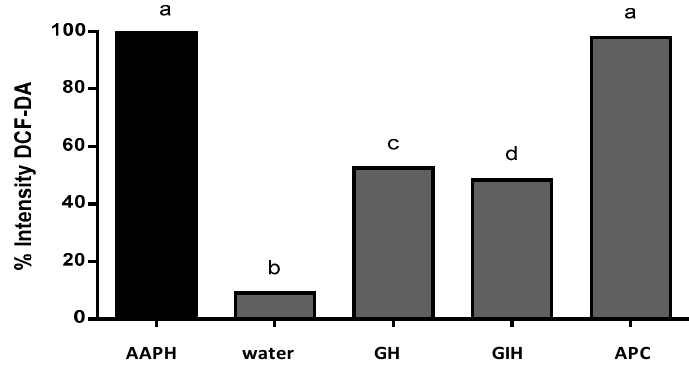
Figure 6. % of intensity by 2,7-dichlorofluorescein diacetate (DCFH-DA) fluorescence in the presence of AAPH. AAPH (positive control), water (basal control without AAPH), GH (gastric hydrolysate incubated with AAPH), IH (intestinal hydrolysate incubated with AAPH), and APC (amaranth protein concentrate incubated with AAPH). Results were analyzed using one-way ANOVA and followed by Tukey´s test. Different letters represents significant differences between samples as p < 0.05 (n = 3).